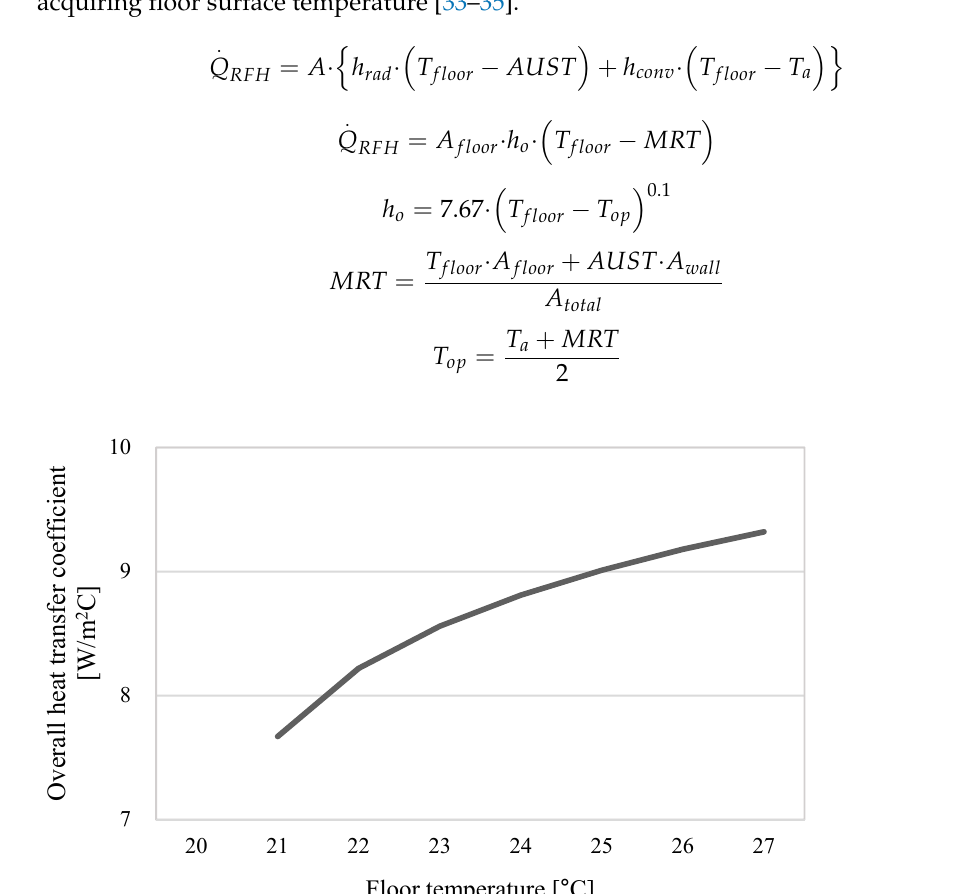
Figure 3. Overall heat transfer coefficient in radiant floor heating system.